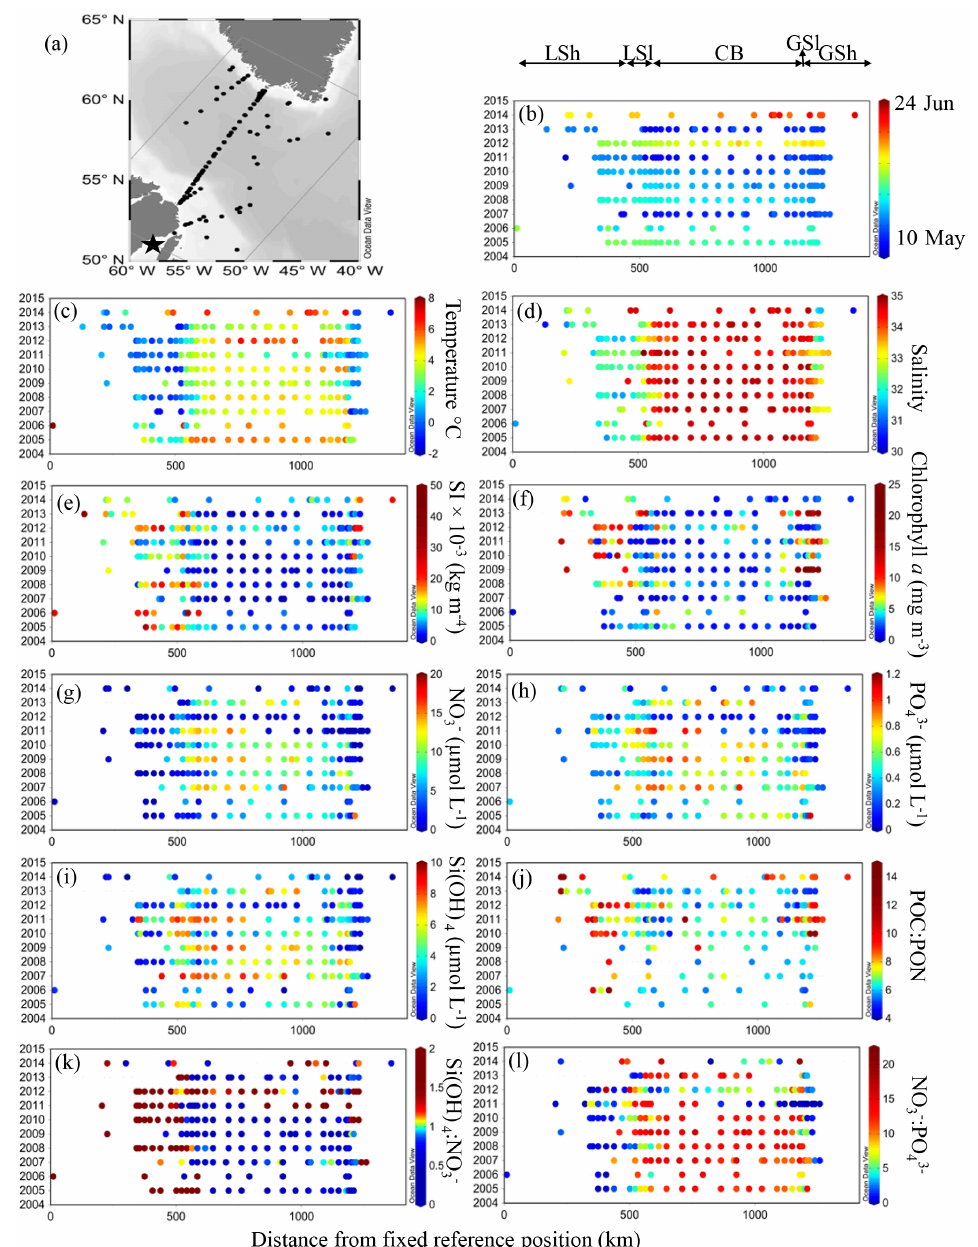
Figure 2. Map with sampling stations and distances from a fixed reference position (Northeast Gulf of St Lawrence) in the x axis shown by the star (a) . Values are given at individual stations sampled between 2005 and 2014 ( y axis) for the following variables: date of sample collection ) (g) , phosphate (PO 3 − ) (h) , silicate (Si(OH) 4 ) (b) , temperature (c) , salinity (d) , stratification index (SI) (e) , chlorophyll a (f) , nitrate (NO − 3 4 ) concentrations (i) , ratios of particulate organic carbon (POC) to particulate organic nitrogen (PON) (j) , silicate to nitrate (Si(OH) 4 :NO − 3 ) ratios (l) . LSh, Labrador Shelf; LSl, Labrador Slope; CB, Central Basin; GSl, Greenland ratios (k) , and nitrate to phosphate (NO − :PO 3 − 3 4 Slope; GSh, Greenland